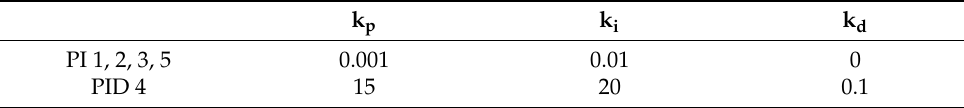
Table 1. Controllers’ gains.